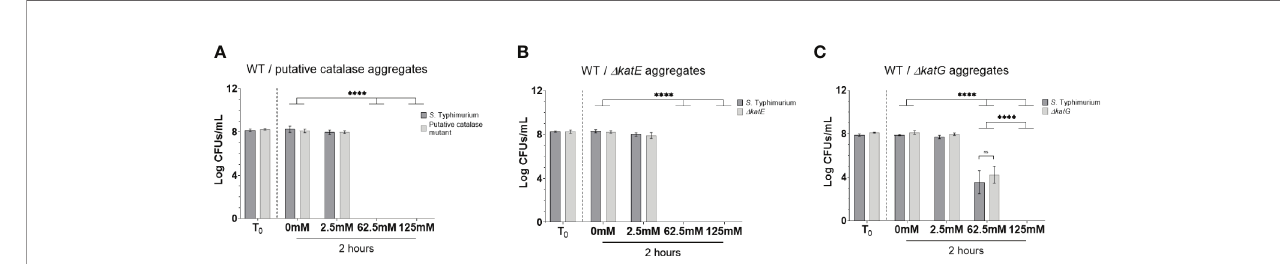
FIGURE 5 | Tolerance of co-cultured WT S . Typhimurium and catalase mutant bio fi lms to H 2 O 2 . (A – C) Bio fi lms were cultured in a 1:1 ratio of WT S. Typhimurium and one other catalase mutant. Bio fi lm aggregates were challenged with H 2 O 2 at a known tolerable dose (2.5 mM) and two challenge doses (62.5 mM and 125 mM) representing tolerance limits for the catalase mutants and WT S. Typhimurium, respectively. Differential antibiotics were used for enumeration and signi fi cant differences were identi fi ed using two-way ANOVA and Tukey method for multiple comparison correction (****p < 0.0001). No signi fi cant differences were observed between WT and mutant at anyone H 2 O 2 concentration. Each experiment was conducted in triplicate and the data represents the mean of three independent experiments. The error bars